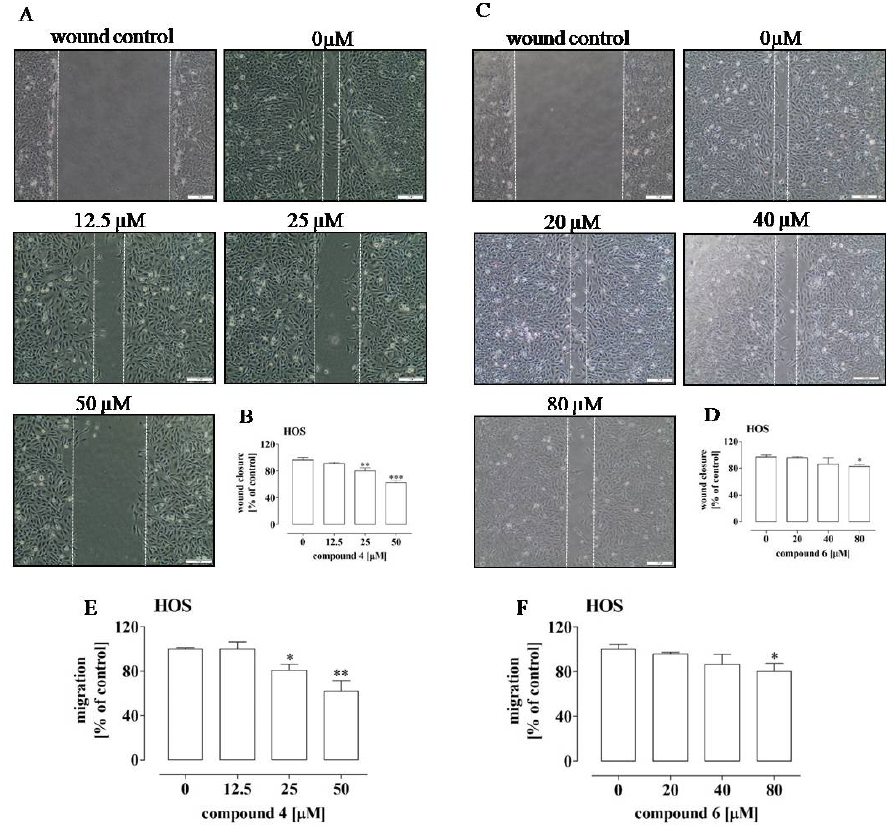
Figure 5. Effect of compounds 4 and 6 on the migration of HOS cells. The cells were treated with the compounds at the indicated concentrations for 24 h. The photos ( A , C ) are representative and correspond with the migration activity of the cells expressed as a percentage of the control untreated cells (0 µM) ( B , D ). The cell migration was determined by means of the wound assay ( A – D ) and the transwell assay ( E , F ). The results are mean values ± SD of at least three independent experiments. Statistically significant differences: *—at p < 0.05; **—at p < 0.01 or ***—at p < 0.001 in comparison with the untreated cells (one-way ANOVA followed by Dunnett’s post-hoc test).